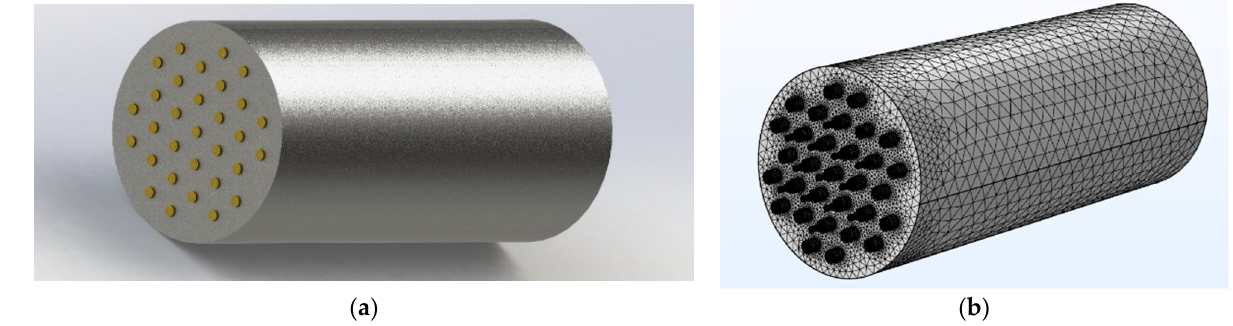
Figure 9. ( a ) Geometry of a compact flame. ( b ) Unstructured mesh of the acoustic field solution. Table 6. Frequency and stability of first-order longitudinal, zero-order tangential, zero-order radi- al modes with different disturbance amplitudes.